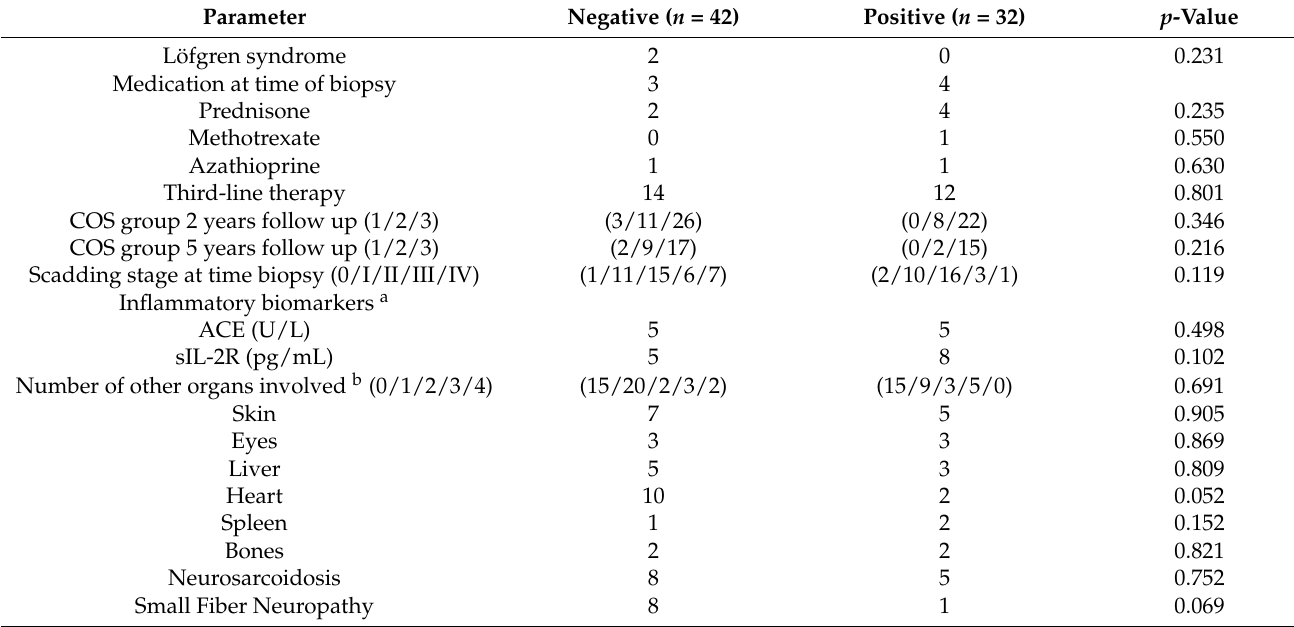
Table 2. Comparison of p-S6 scores in sarcoidosis patients according to medication use, need for third-line therapy, inflammatory biomarkers and organ involvement. The negative group consists of patients with IHC-score of 0, the positive group consists of patients with IHC-score above 0.